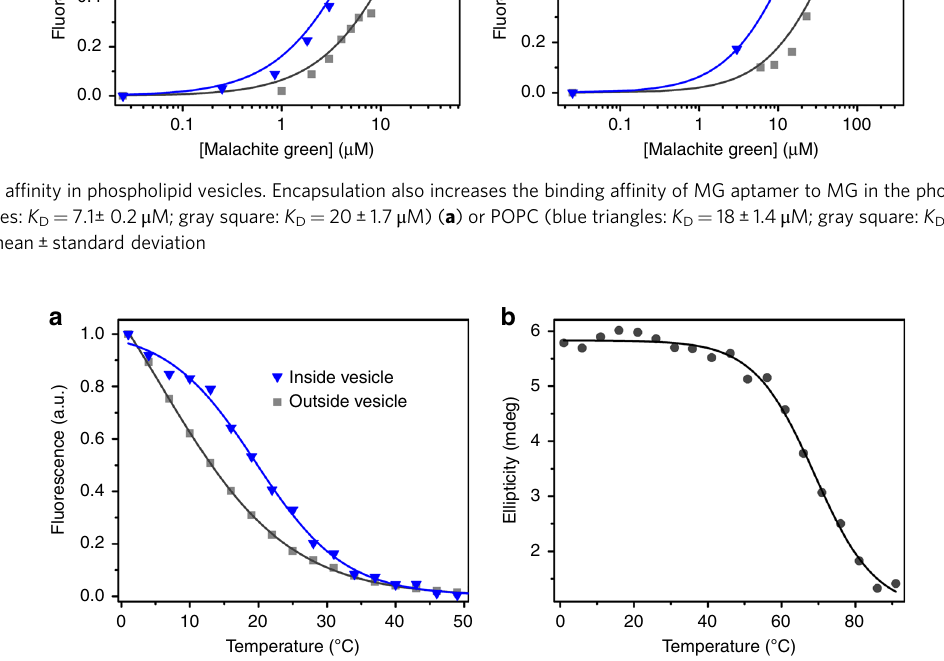
Fig. 4 Melting transitions of the MG aptamer. a Fluorescence response of the MG aptamer with temperature in the presence of saturating MG concentrations ( ∼ 3-fold above the K D ), for aptamer exposed to empty MA vesicles (gray squares) and aptamer inside MA vesicles (blue triangles). Shown are representative data along with the curve fi t to the Boltzmann sigmoidal equation. Note that because the fl uorescence of the aptamer exposed to empty vesicles does not show saturation in the measured temperature range, the point of half-maximal measured intensity does not necessarily correspond to the estimated T t . b CD response (at 264 nm) of the dye-bound MG aptamer at varying temperatures in buffer without vesicles ( T m = 71 ± 2 °C). Values given are mean ± standard